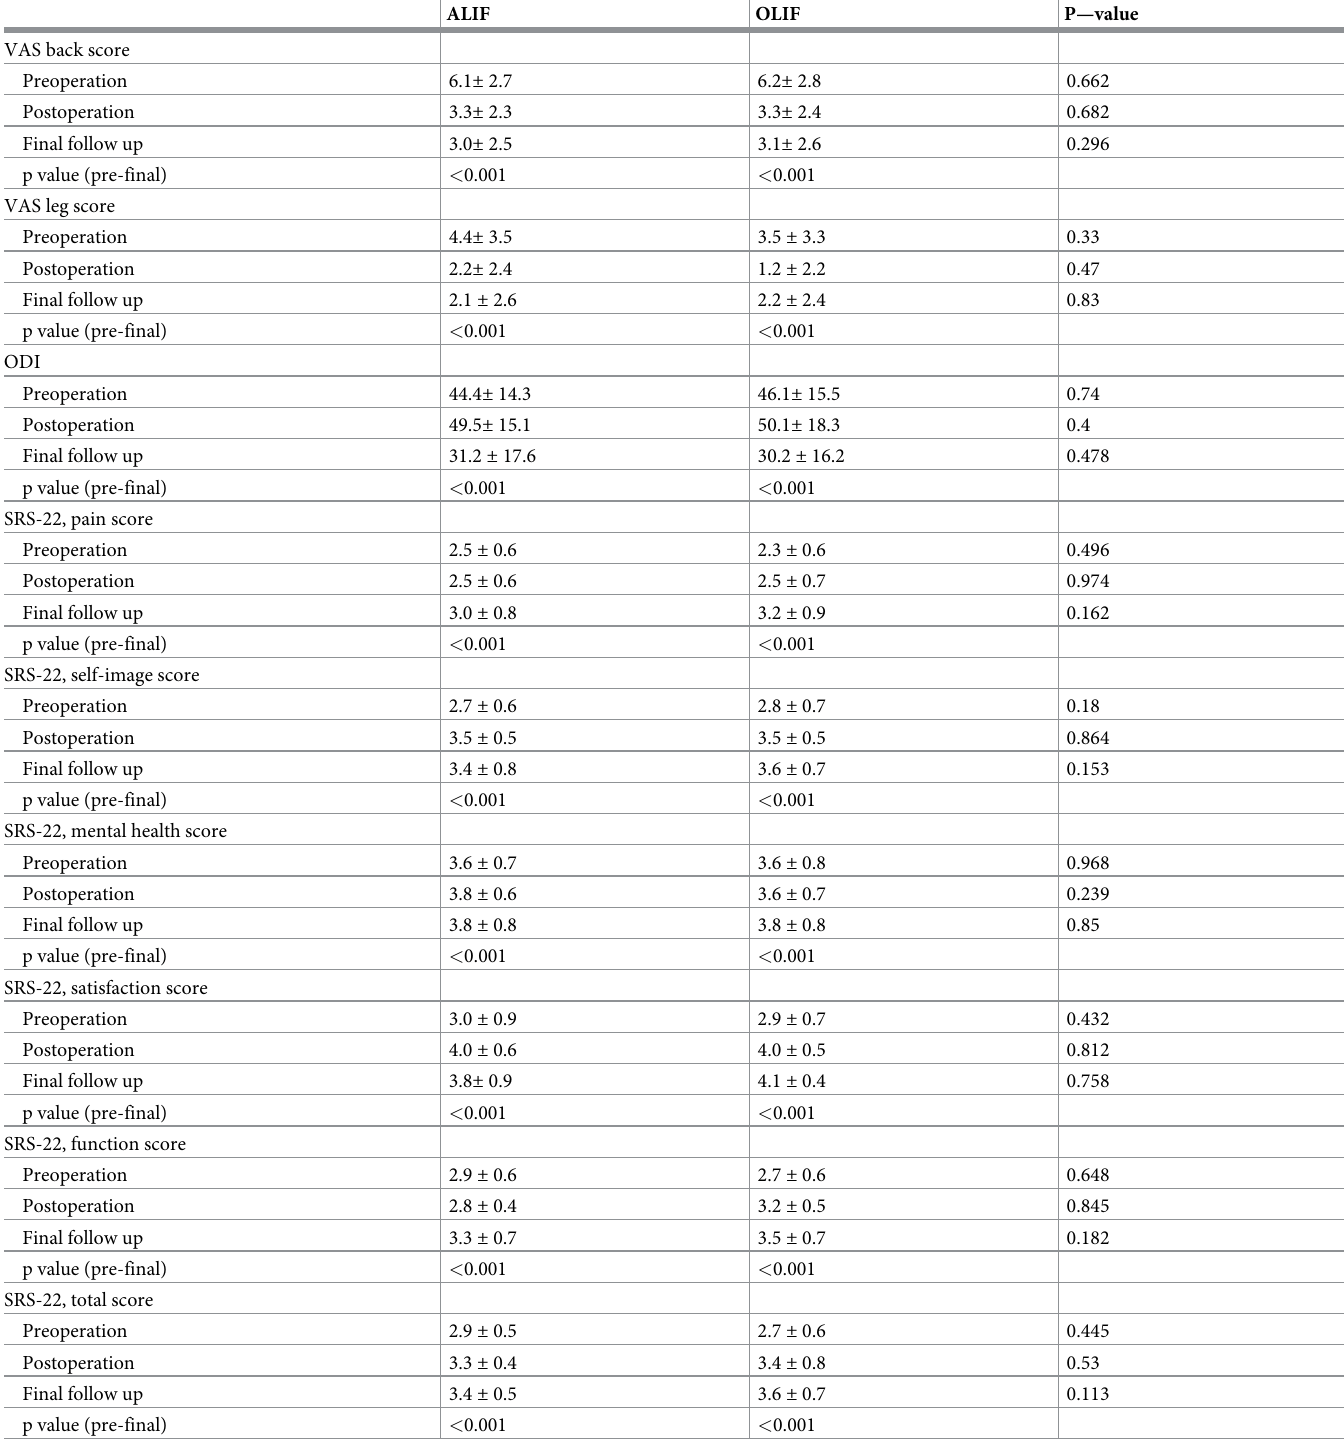
Table 3. Comparisons of clinical outcomes between the two